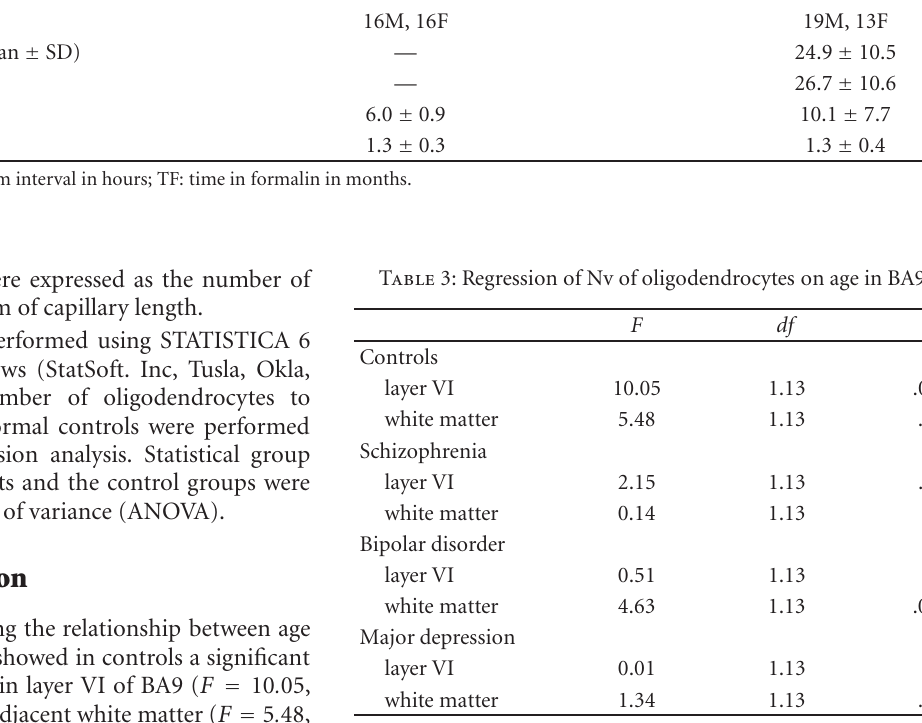
neuroleptics dosage and Nv of oligodendrocytes in schizophrenia showed no significant neuroleptics by age interaction in layer VI of BA10 ( F = 3 . 15, df = 1 . 30, P = . 09) and in adjacent white matter ( F = 0 . 18, df = 1 . 30, P = .